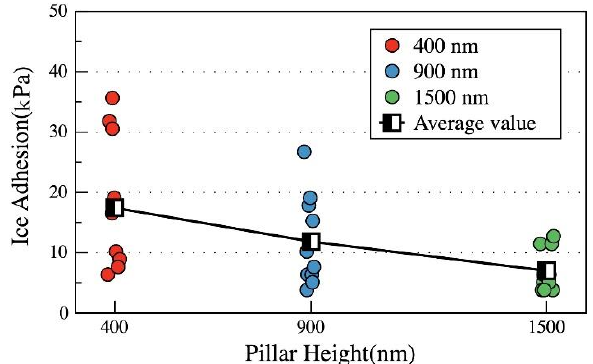
Figure 10. The ice adhesion of hydrophobic nano-pillar array fluoridated epoxy (1 wt %).